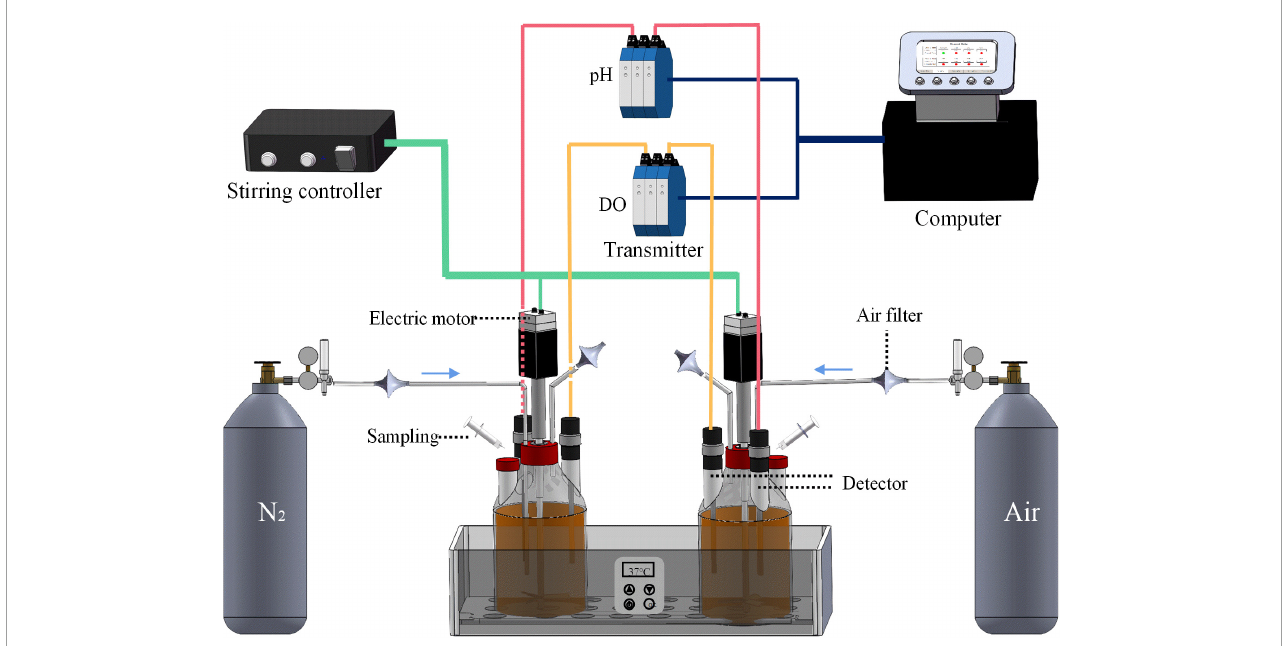
FIGURE1 The bioreactor system used for the fermentation of Polygonati Rhizoma with Lactiplantibacillus plantarum under aerobic and anaerobic conditions. The pH detector and DO detector are connected to the computer through the transmitter, which can monitor the values of pH and DO of the broths in real-time, and promptly feedback the results to the